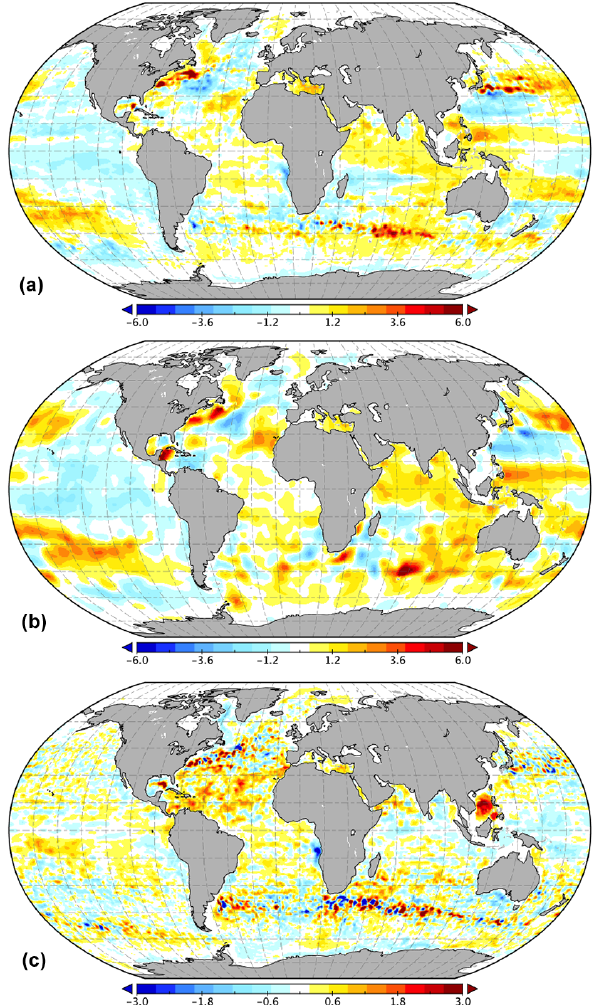
Figure 10. (a) Top 2000m heat content linear trend over the pe- riod 2005–2013 in C-GLORSv5, (b) NOAA/NODC data from Lev- itus et al. (2012), and (c) difference between C-GLORSv5 and C- GLORSv4. Units are 1 × 10 + 18 Jyear − 1